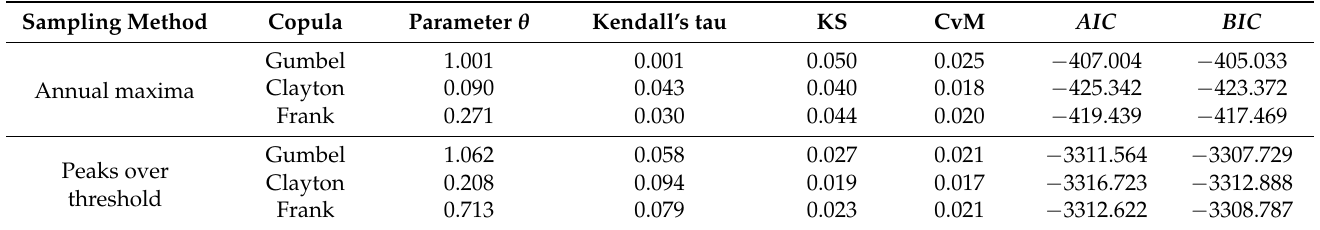
Figure 6. Comparison of empirical and theoretical cumulative distribution function values based on the fitted copulas. Table 5. Parameters and goodness-of-fit test statistics for Archimedean